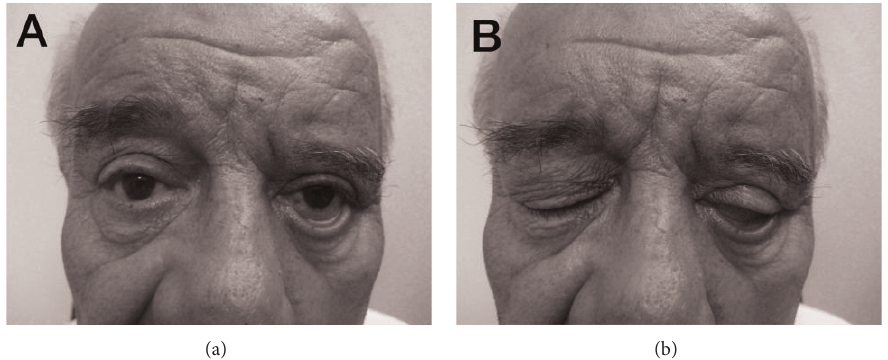
Figure 1: A 74-year-old man with left facial nerve palsy associated with marked brow ptosis, dermatochalasis, and lower eyelid laxicity (a). Complete closure of the right upper eyelid. Scleral show due to lower eyelid laxicity